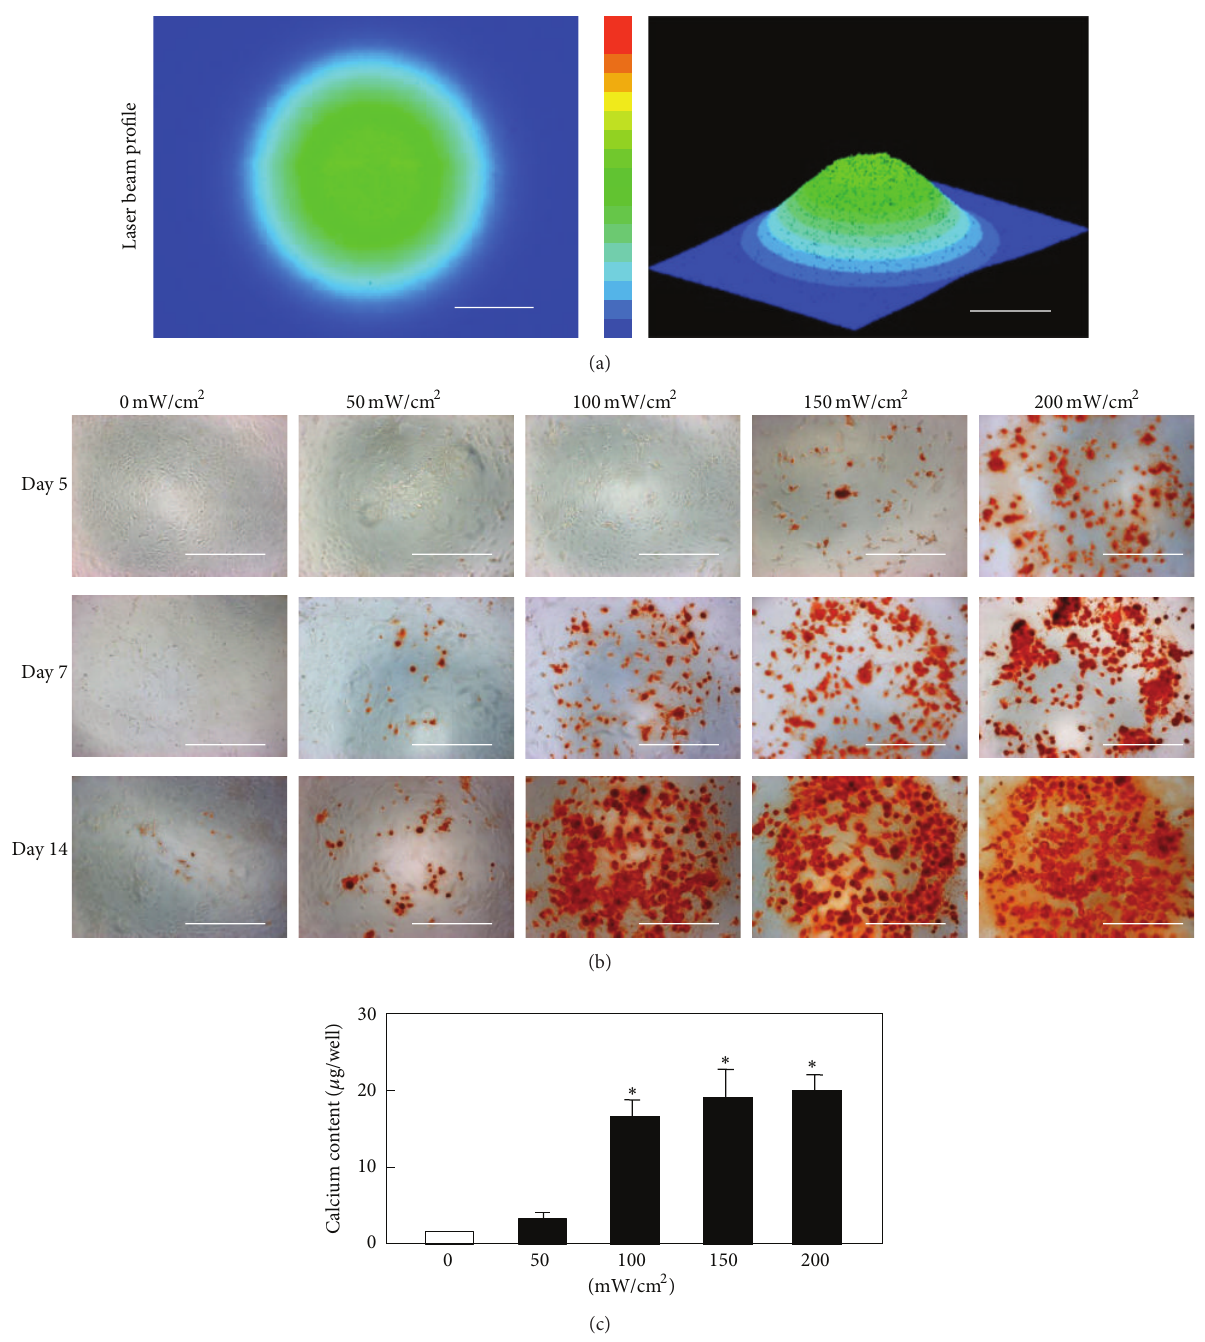
Figure 1: (a) The beam profile of the blue laser (wavelength: 405 nm) used in this study (scale bars: 200 𝜇 m). MSCs were irradiated for 180 sec at various laser power levels. (b) Alizarin red S staining of irradiated MSCs (magnification 50x; scale bars: 400 𝜇 m). After laser irradiation, calcium deposition had increased around the cells in a dose-dependent manner. (c) The quantitative calcium content increased after blue laser irradiation (day 14) relative to nonirradiated cells. Calcium content increases varied with laser energy level ( ∗ 𝑃 < 0.01 , indicating significant difference between the calcium content of laser-irradiated MSCs and controls)